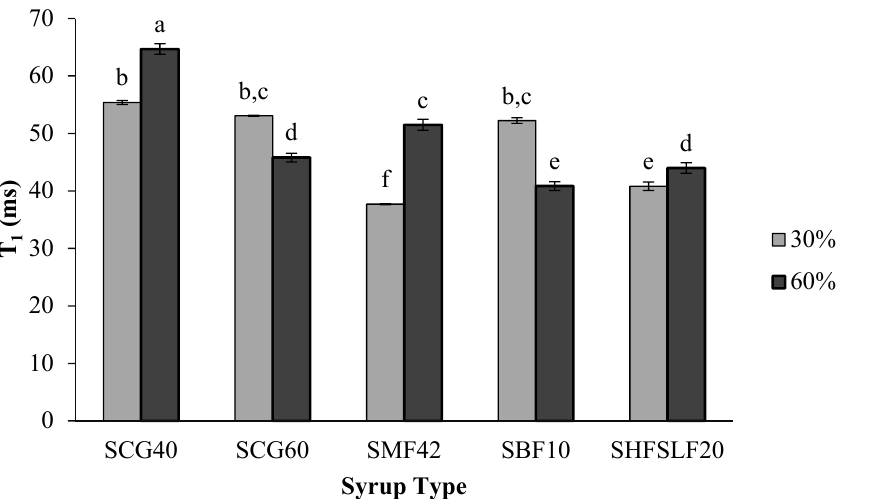
Figure 4. Effect of corn syrup type and concentration on the T 1 of the formulated candies. Small letters indicate the significant differences ( p < 0.05) between the samples. Each bar represents a different sample. Errors are represented as standard errors.